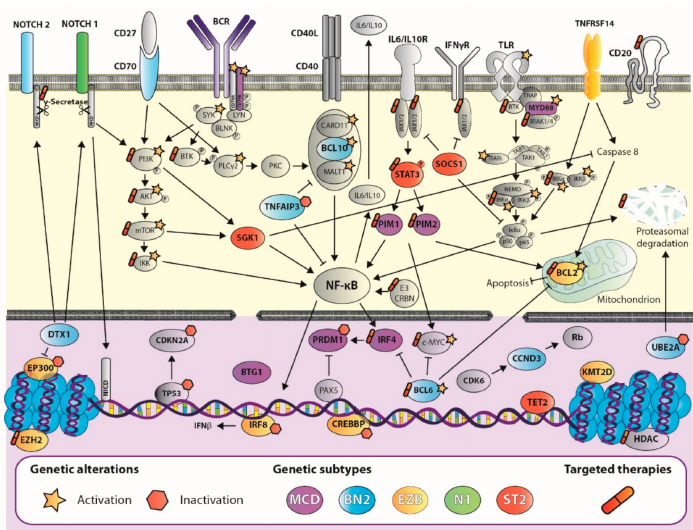
Figure 1. Diffuse large B-cell lymphoma complexity: untangling the networks underlying genetic subtypes. Schematic view of the most relevant genetic events in B-cell physiology pathways for each genetic subtype (GS) highlighted in purple (MCD), light blue (BN2), yellow (EZB), green (N1), or red (ST2), as described in the figure key. Mutations in CD79A and CD79B and SYK lead to chronic activation of the B-cell receptor (BCR; of special importance in the MCD GS), which triggers the activation of SYK, BTK, and PKC promoting the formation of the CARD11-BCL10-MALT1 complex. Mutations in genes that encode all the components in this complex can be identified in a subset of DLBCLs and are especially relevant for the BN2 GS. Mutations in genes that encode MYD88, IRAK1, and IRAK4 activate Toll-like receptor (TLR) signaling, which is further promoted by alterations in positive regulators downstream TLR, such as TRAF6. Alterations in Notch signaling, binding of CD27 to CD70, and BCR activation also lead to abnormal activation of PI3K-AKT-mTOR pathway, which also presents genetic alterations in this disorder. Most of these pathways converge in the activation of IKK and downstream NF- κ B signaling, promoting lymphomagenesis. Tumor cell survival is boosted by alterations in the BLC2 and BCL6 axis, TP53, and imbalances in cytokine related pathways: interleukins (IL), interferon gamma (IFN γ ), or tumor necrosis factor (TNF), which overall lead to increased survival and decreased apoptosis in these cells. Alterations at the nuclear level are also common in all genetic subtypes (except for the N1 subtype), and involve p53, DNA damage pathway, epigenetic regulators, and other components involved in proliferation and survival cell processes. Currently, there are targeted therapies against several components downstream these pathways (tagged with a pill icon). Activating genetic events are highlighted with a star, while those involving inactivation are flagged with a